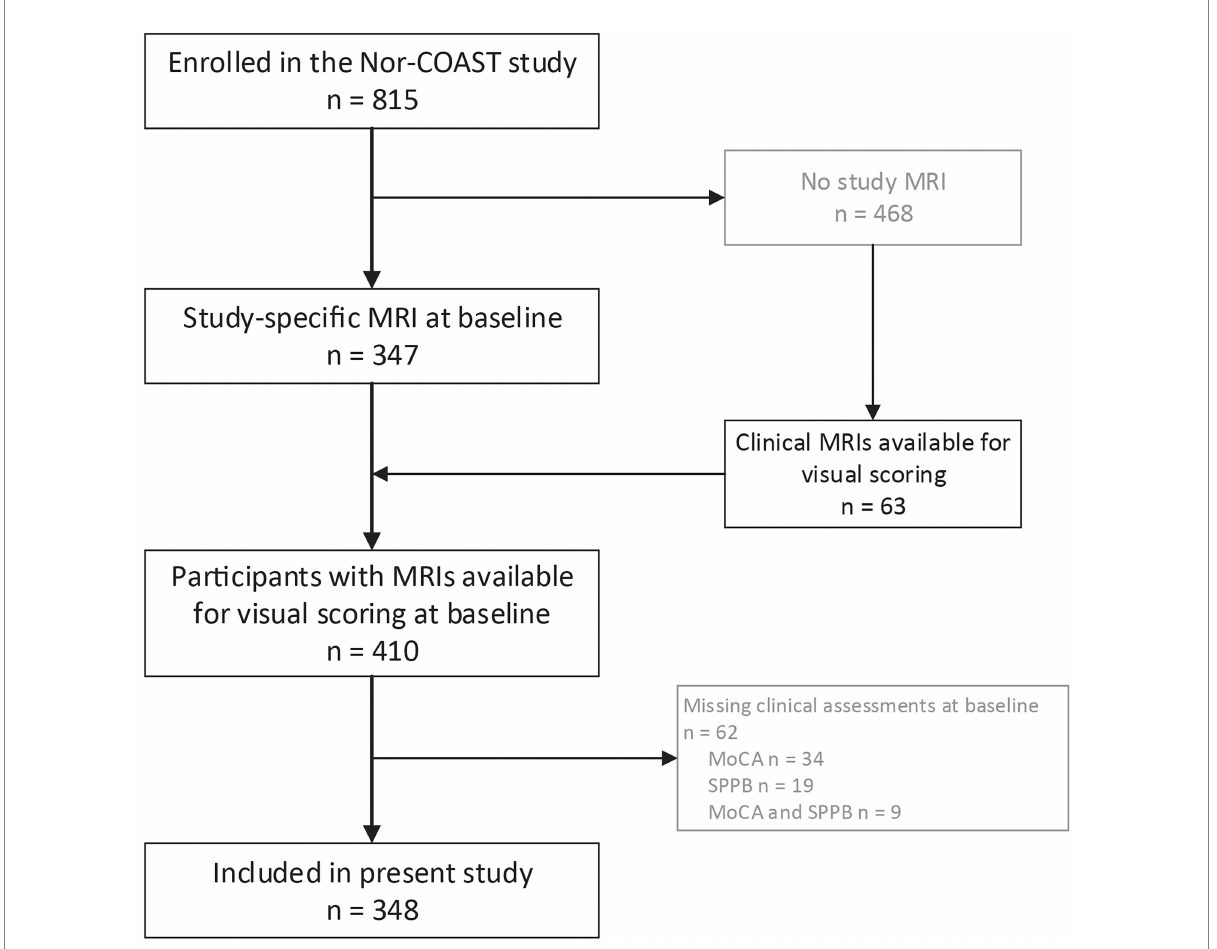
FIGURE 1 Flow chart on inclusion. MoCA-Montreal Cognitive Assessment; MRI-magnetic resonance imaging; Nor-COAST, Norwegian Cognitive Impairment After Stroke; SPPB-Short Physical Performance